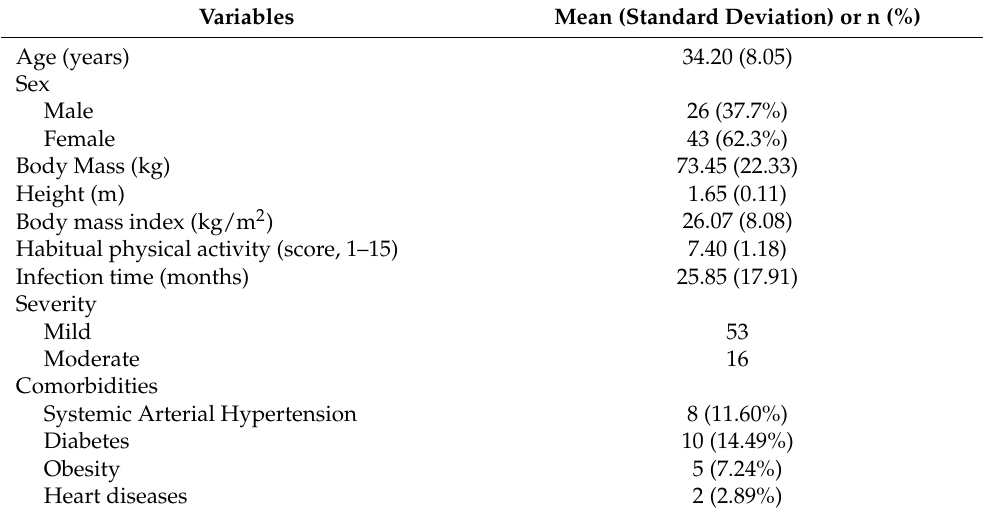
Table 1. Personal and clinical characteristics of the study